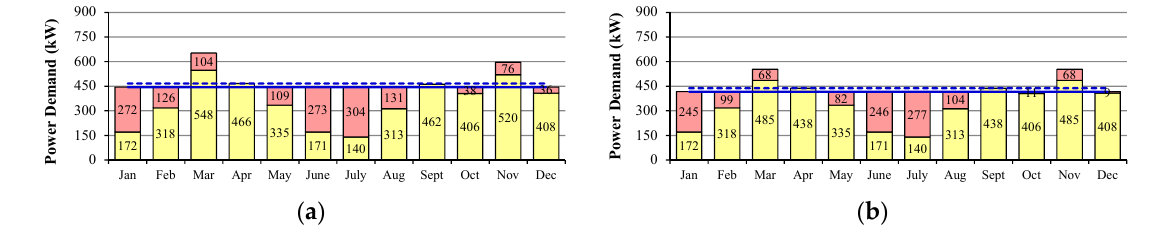
Figure 9. Graph using biogas and diesel generator set for: ( a ) March and ( b ) November.